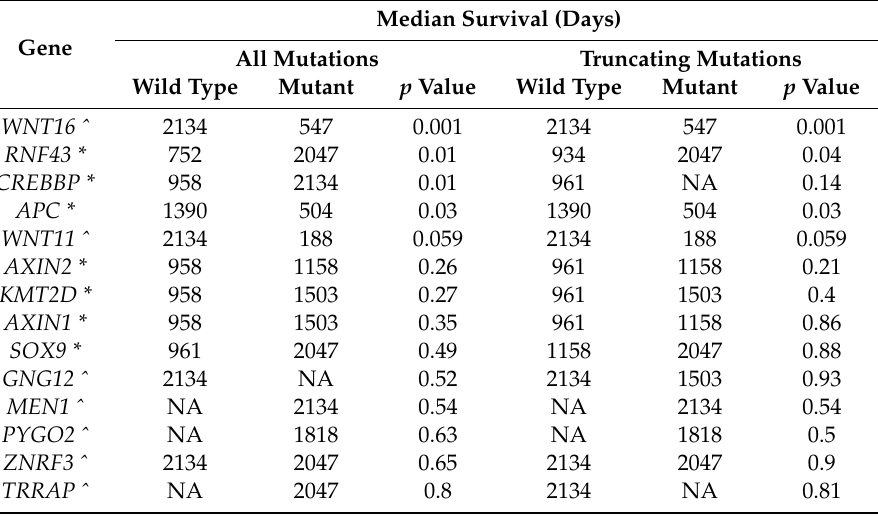
Table 3. Univariate survival analysis of the most frequently mutated WNT signaling regulators, and WNT signaling regulators identified as potential drivers by computational analysis. Di ff erences in overall survival were assessed using the log-rank test. Median Survival (Days) Gene All Mutations Truncating Mutations Wild Type Mutant p Value Wild Type Mutant p Value WNT16 ˆ 2134 547 0.001